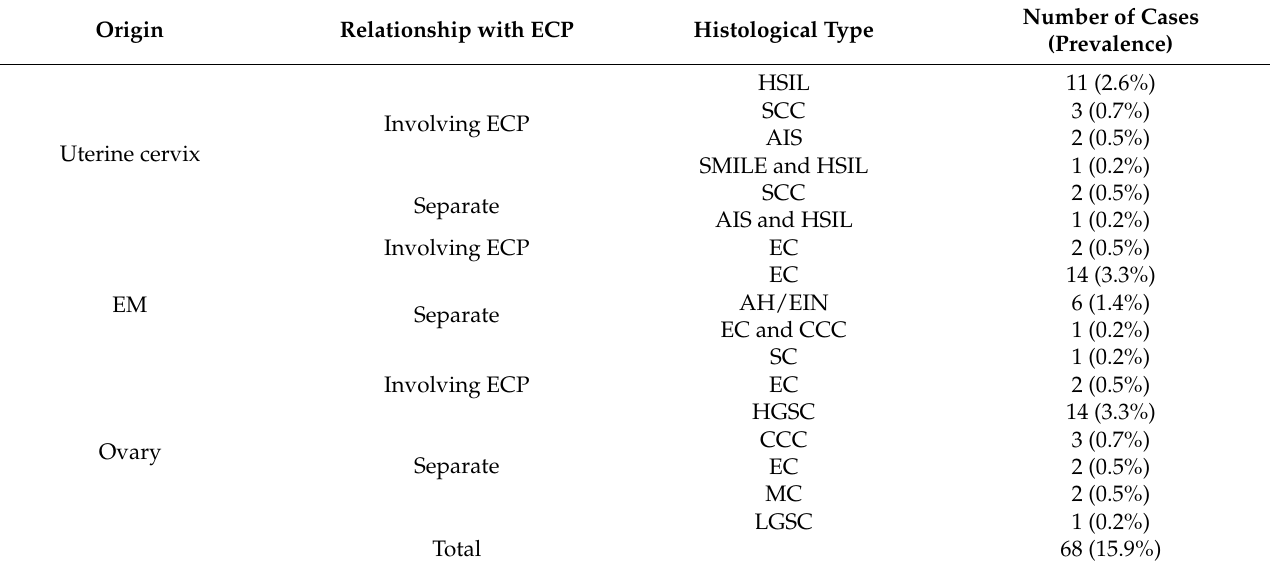
Table 1. The histological types and prevalence of gynecological tumors co-existing with ECP. Number of Histological Type